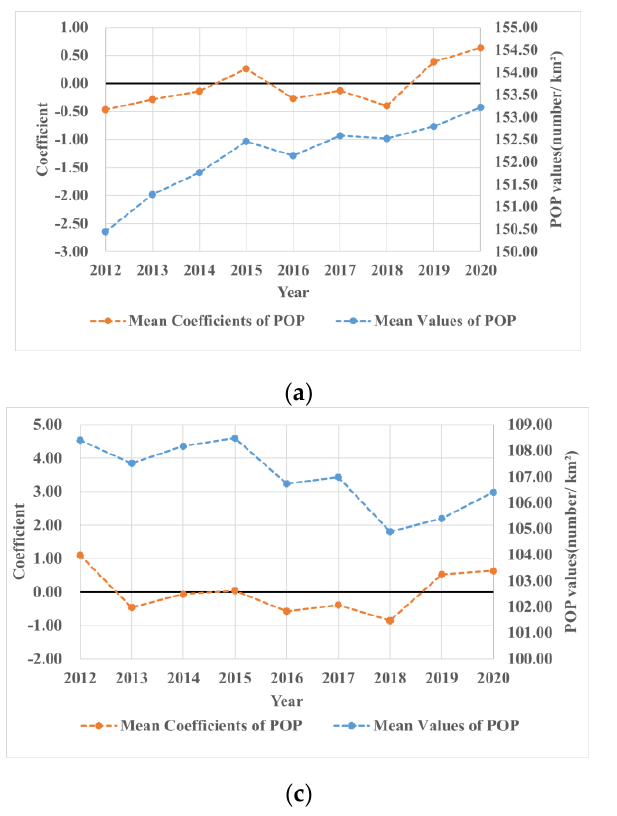
Figure 10. Temporal trends of mean POP values and mean POP coefficients in ( a ) Anqing; ( b ) Hefei; ( c ) Lu’an.